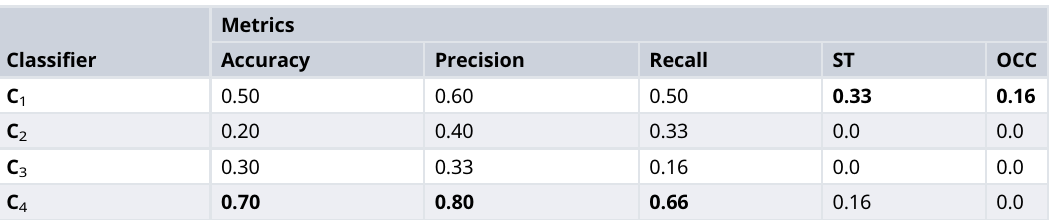
Table 4. Traditional vs MARS Metrics for the worked example.